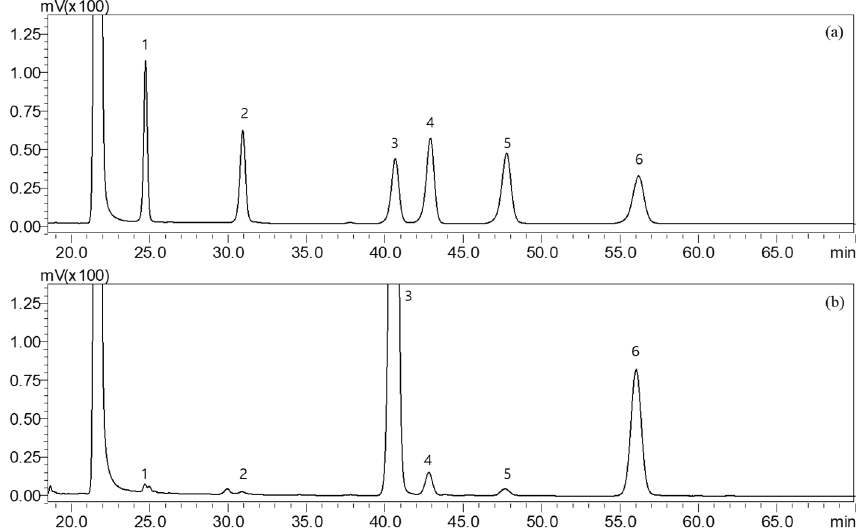
Figure 1. HPLC chromatograms of PMP-derivatized monosaccharides. Peaks in ( a ) mixed standard and ( b ) hot-water extract of SH were analyzed by HPLC. Peak #1. mannose; 2. rhamnose; 3. glucose; 4. galactose; 5. xylose; 6. fucose. Table 1. Determination of the component monosaccharides identified in SH.